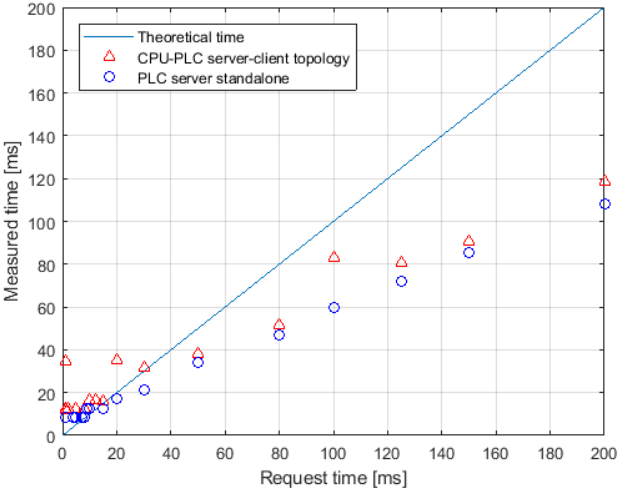
Figure 14. Diagram of the requested and actual response time for the client-external server system and for the system where the PLC is a server.